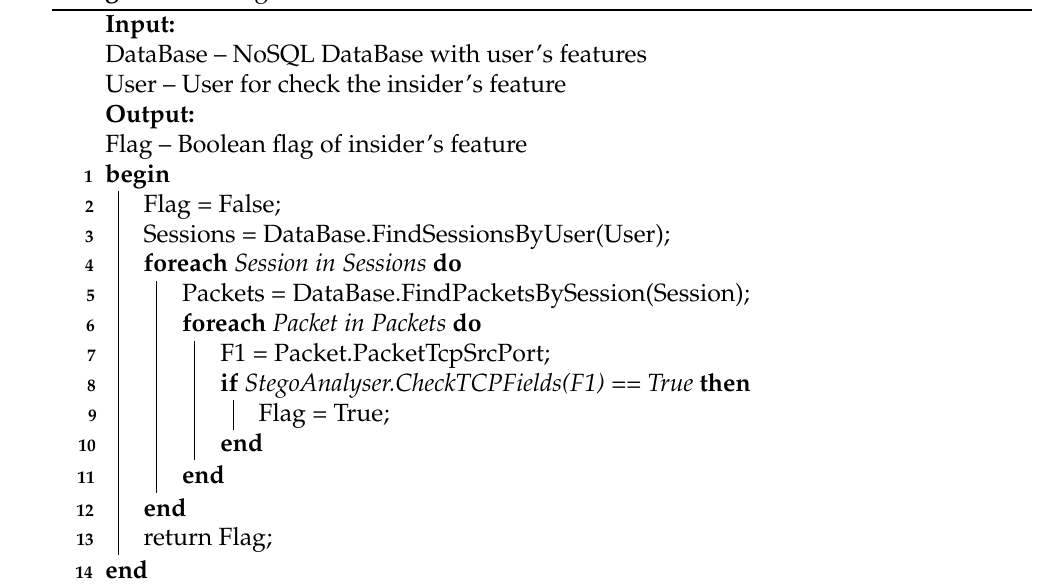
Algorithm 5: Algorithm for Feature